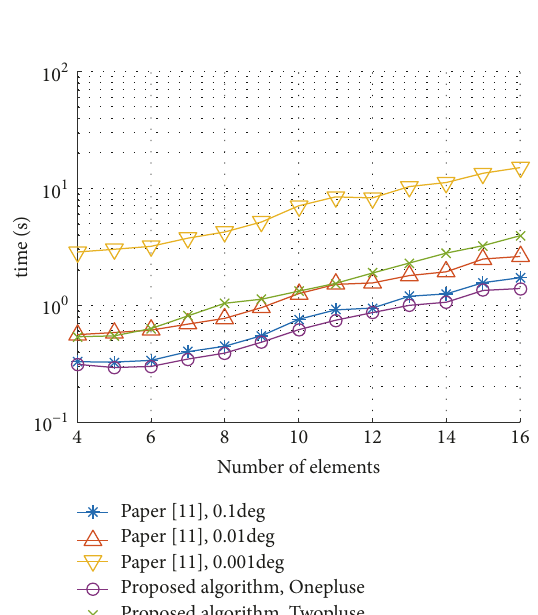
Figure 4: RMSE estimation results.